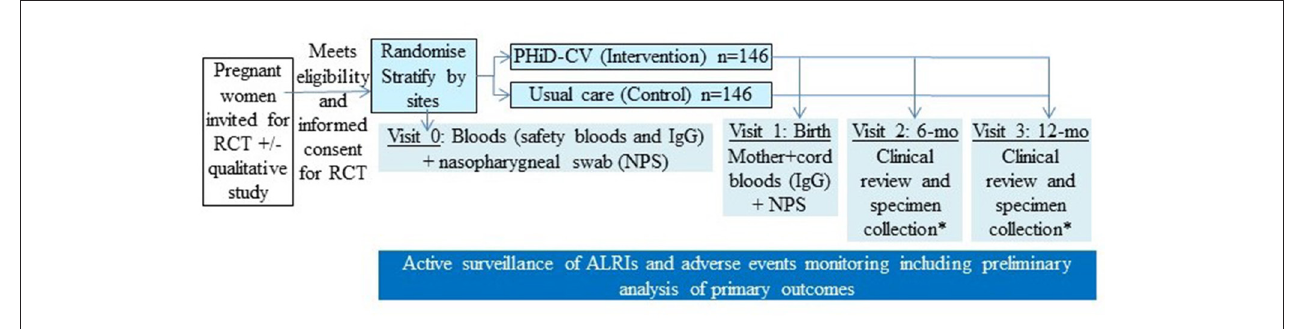
FIGURE 1 | Overall schematic study design of our randomised controlled trial (RCT). *In a subset of infants, specimen collection includes nasopharyngeal swab (NPS) and infant blood (for immunoglobulins and peripheral blood mononuclear cells). PHiD-CV, 10-valent pneumococcal conjugate Haemophilus influenzae (Hi) Protein D vaccine.